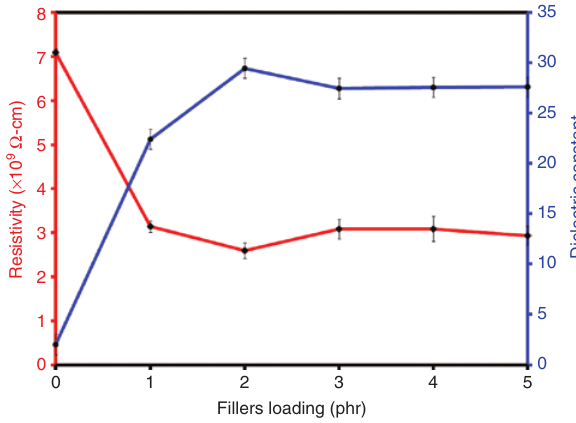
Figure 8: Inverse correlation between resistivity and dielectric constant as a function of filler